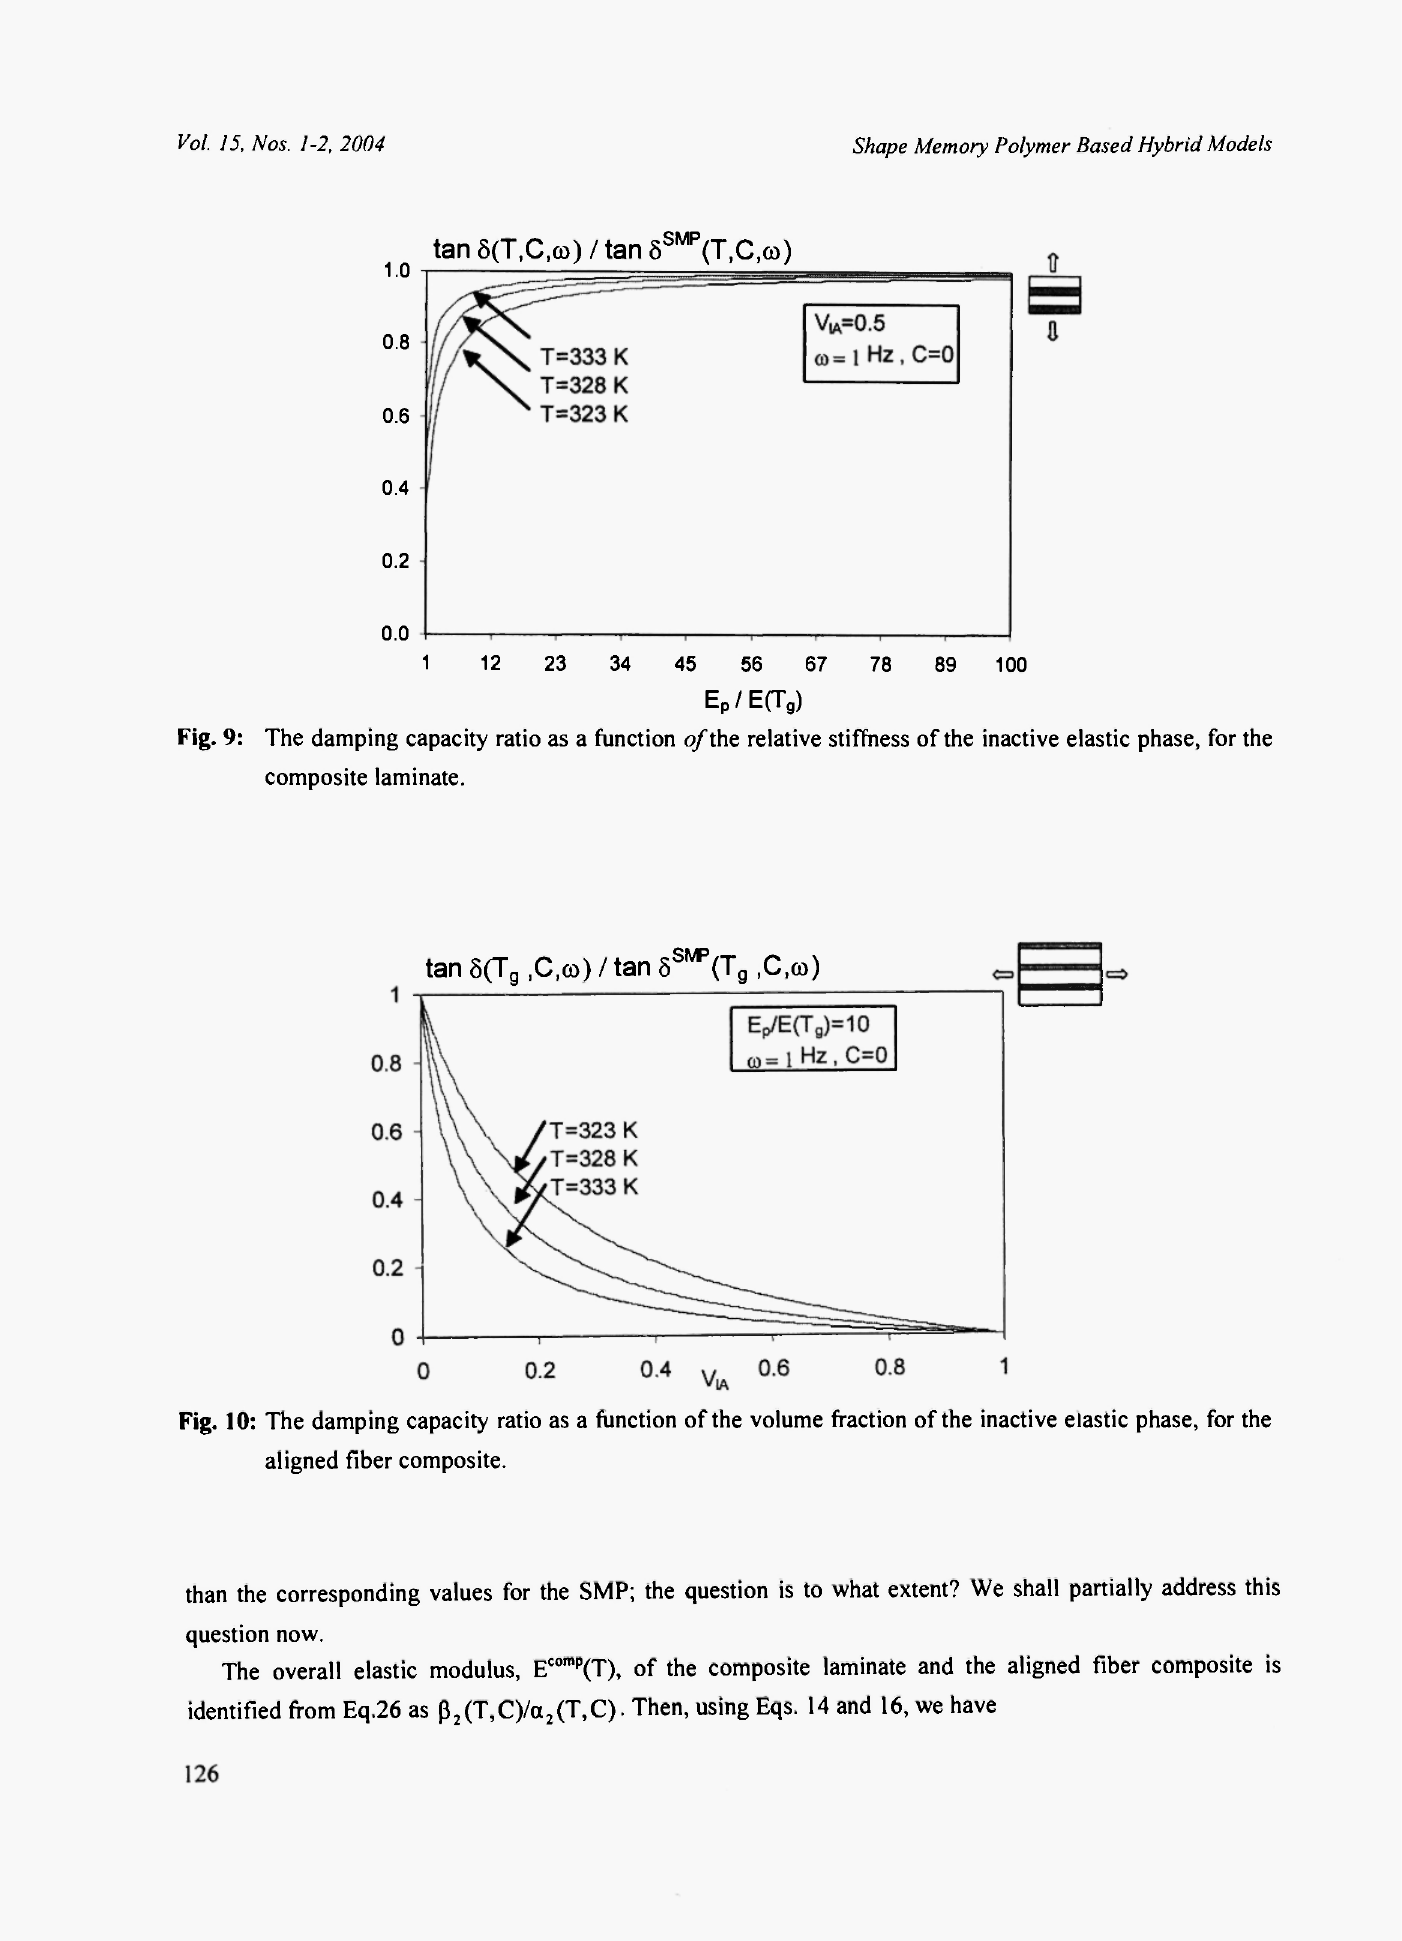
Fig. 9: The damping capacity ratio as a function of the relative stiffness of the inactive elastic phase, for the composite laminate.